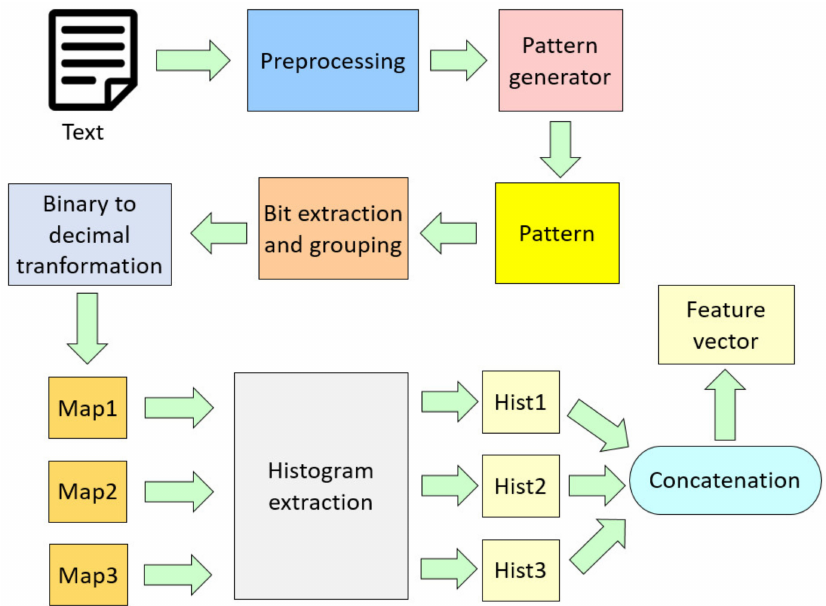
Figure 2. Block diagram of the proposed text-based feature extraction function generation